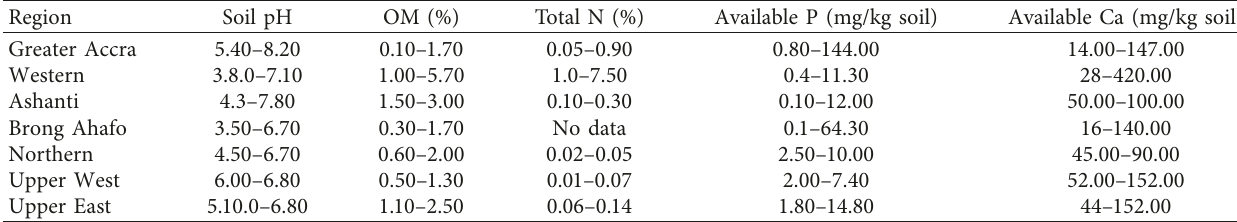
Table 1: Average soil fertility status of seven administrative regions of